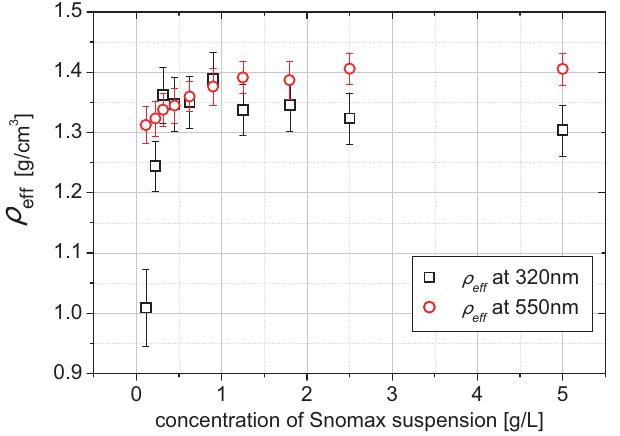
Figure 3. The effective density of Snomax measured for particles generated from differently concentrated suspensions for two differ- ent dry particle sizes.